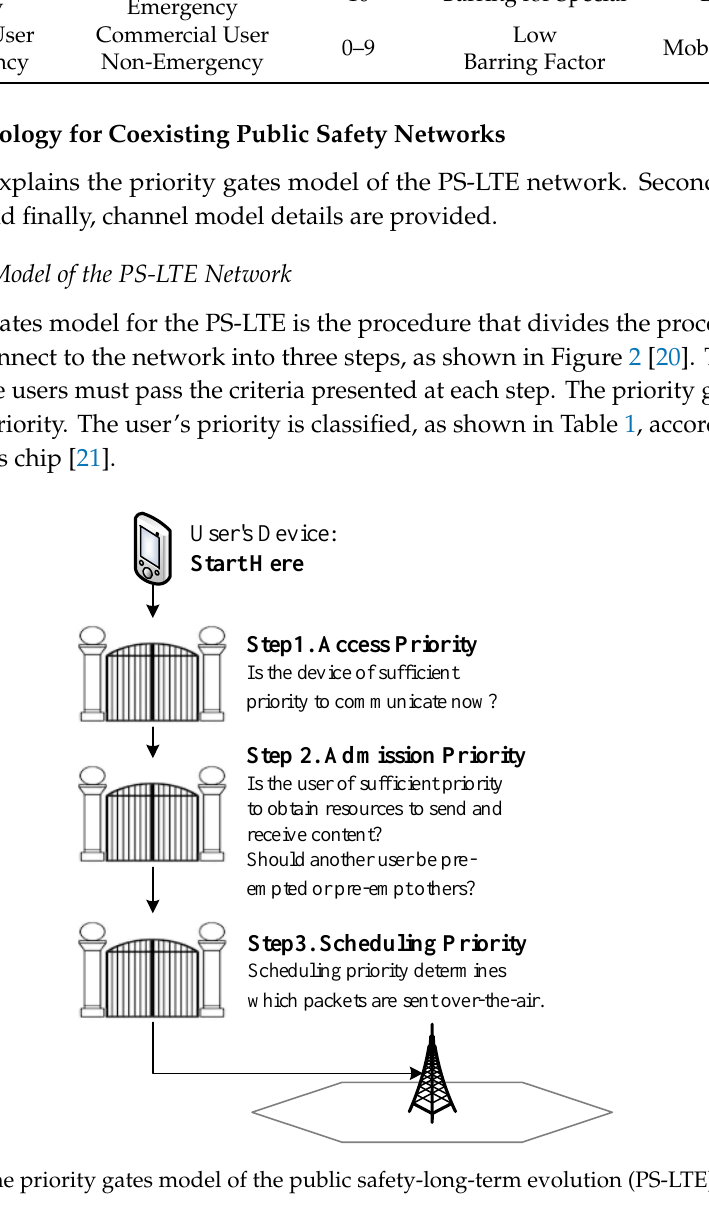
Figure 2. The priority gates model of the public safety-long-term evolution (PS-LTE)